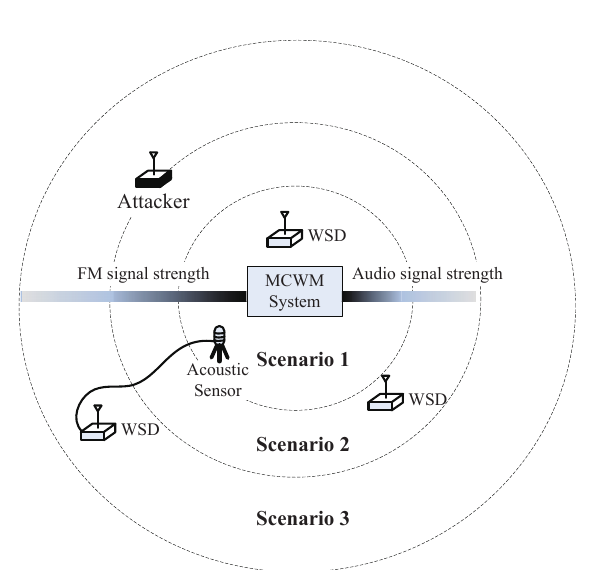
Figure 1. The system model and three scenarios considered in this paper. Scenarios differ from each other in the qualities of FM signals and acoustic